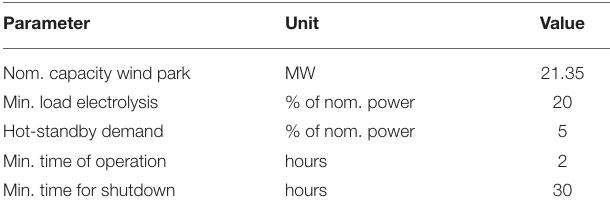
TABLE 2 | Direct supply operation